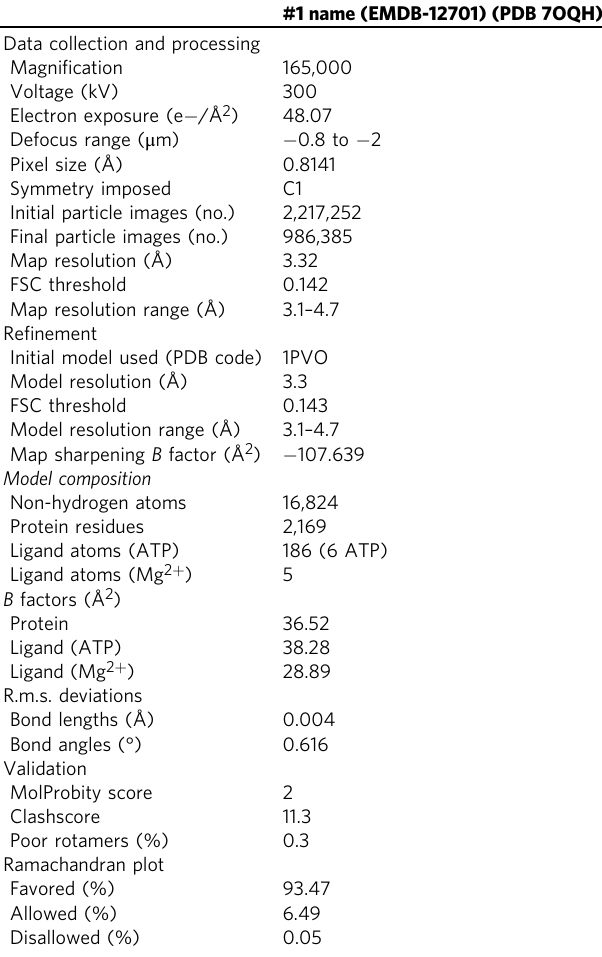
Table 1 Cryo-EM data collection, re fi nement, and validation